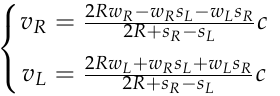
a a  , L and under typical road conditions.